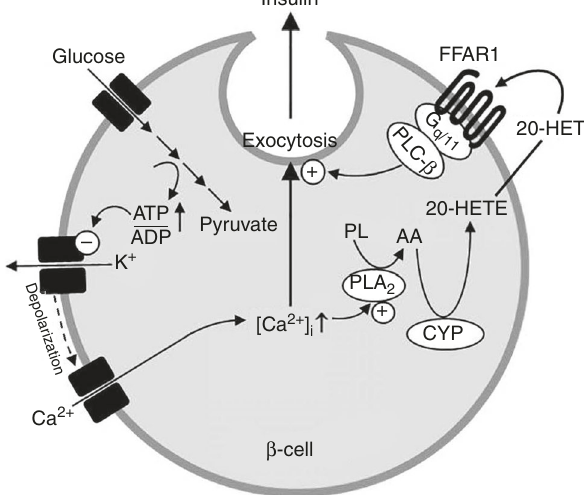
Fig. 6 Model of 20-HETE-mediated stimulation of GSIS through FFAR1. Glucose-induced increases in intracellular [Ca 2+ ] result in phospholipase A 2 (PLA 2 ) activation. Arachidonic acid (AA) produced by PLA 2 from phospholipids (PL) is then further converted by CYP ω -hydroxylases to 20- HETE, which in an auto- and/or paracrine fashion activates the G q /G 11 - coupled FFAR1 receptor. Downstream signaling induced by activated FFAR1 promotes